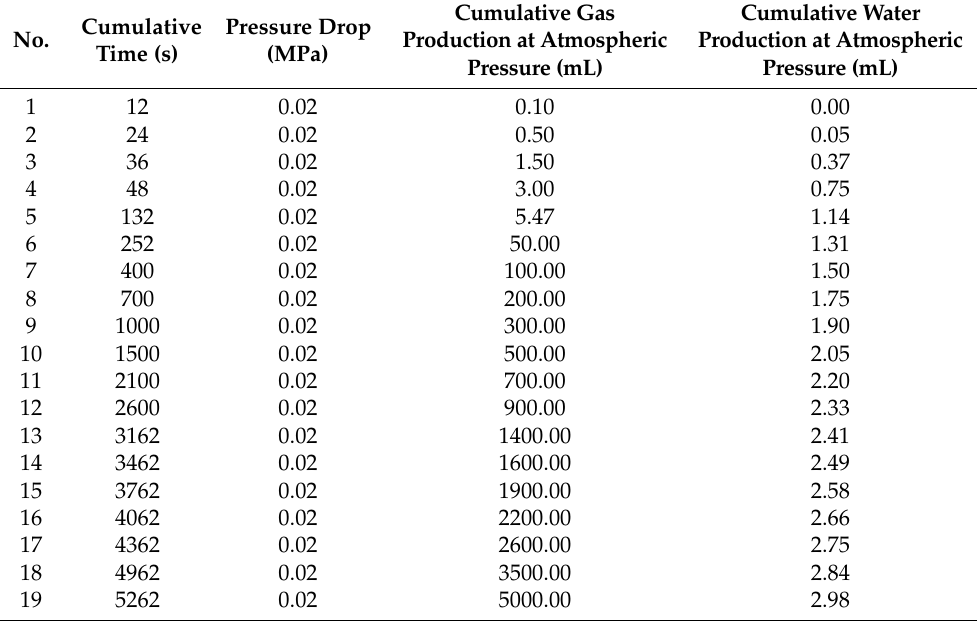
Table A4. The experimental results of No.4 (The mass of saturated water is 4.64